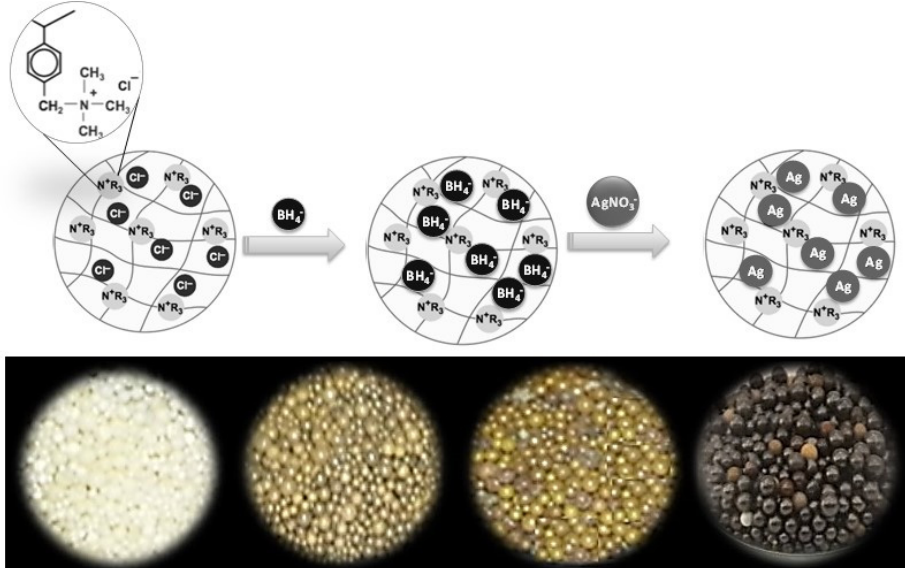
Figure 1. Schematic illustration of the preparation of a hybrid anion exchange resin impregnated with Ag NPs (top) and their visual appearance when prepared with increasing AgNO 3 concentrations (bottom). The color of Ag ‐ resin beads changed from yellow to yellow ‐ brown and finally brown ‐ black with increasing AgNO 3 concentration.